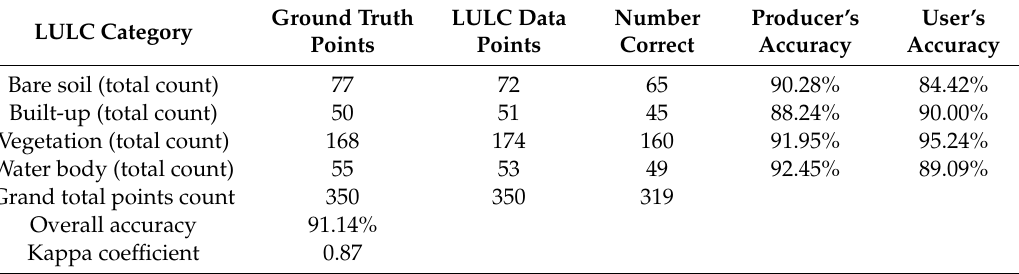
Table 2. The error matrix for the classified image of 1989.